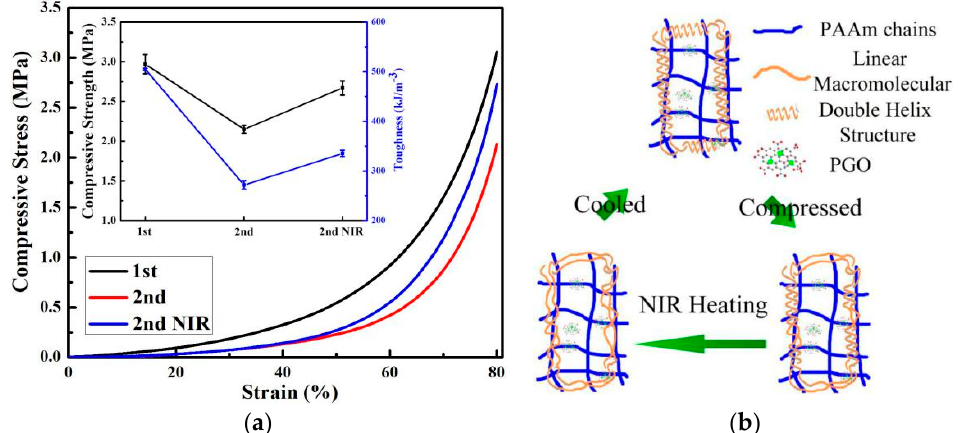
Figure 7. ( a ) The compressive stress-strain curves of PDN gels at 1st compression, 2nd compression, and 2nd compression with NIR laser. The insert is the comparison of their toughness and compressive strength. ( b ) Schematic diagram of NIR photothermal recovery of PDN hydrogels.